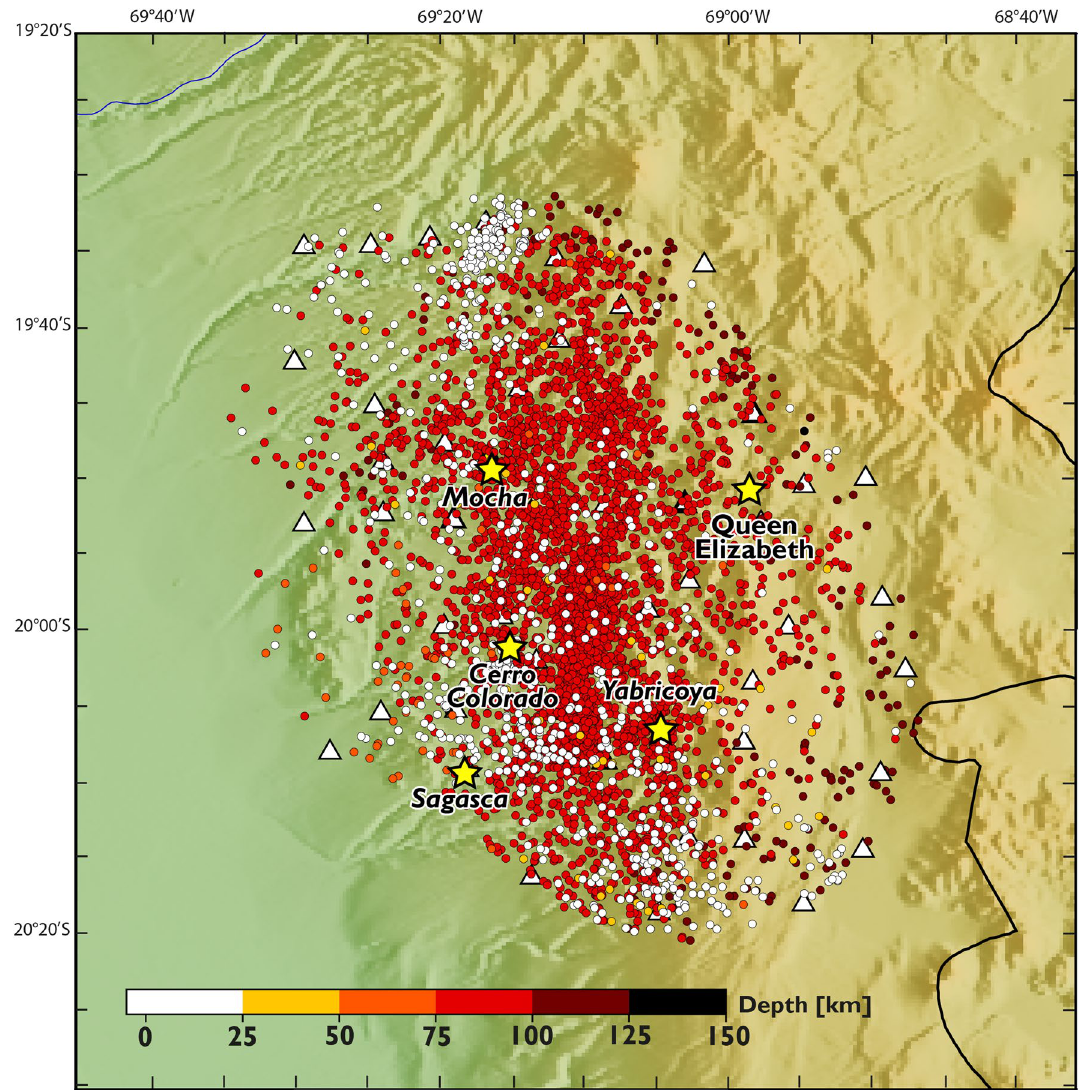
Figure 3. Distribution of the seismicity used for the Vp/Vs models determination. The color of the circles is associated to the depth scale shown in the bottom of the figure. White triangles correspond to the seismic stations, and yellow starts correspond to known porphyry copper deposits and prospects in the study area. The software used to generate this figure was QGIS 3.22 (www. qgis.